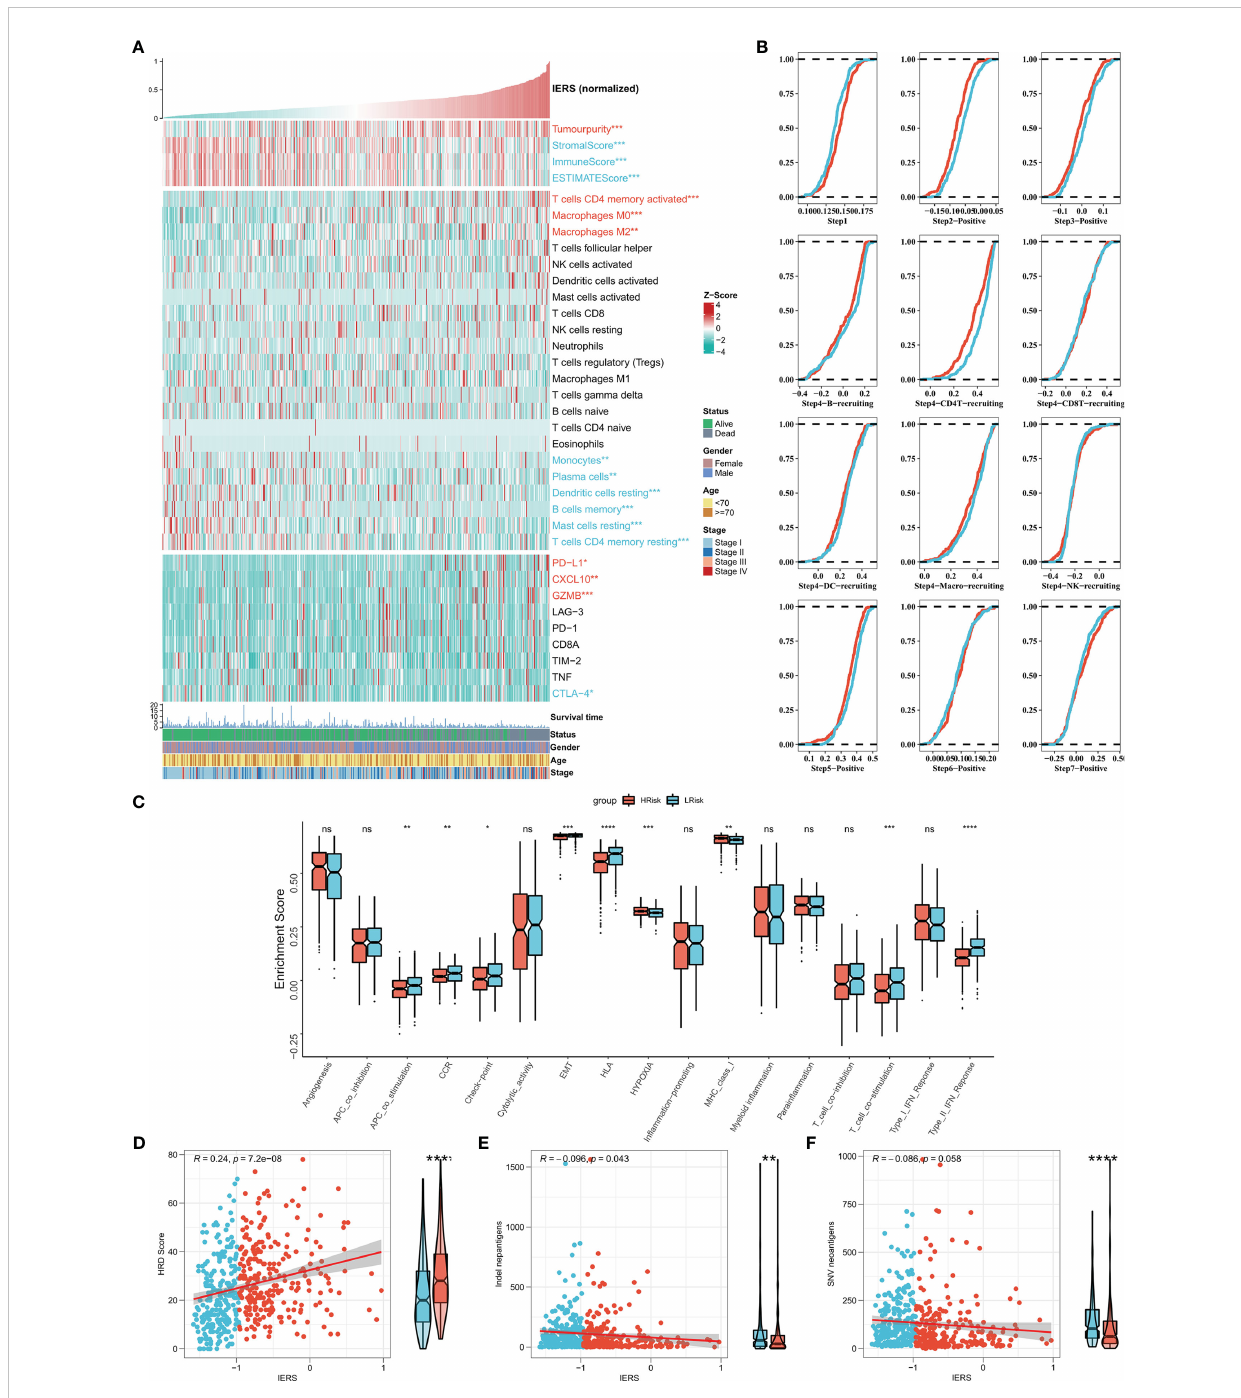
FIGURE 6 Dissecting the heterogeneity of TME among IERS subgroups (A) Heat map showed the IERS landscape, including the Estimate score, immune cell in fi ltration abundances, and immune checkpoint expression. (B) Cumulative distribution plots show differences in immune processes between different IERS subgroups. (C) The box plot showed the difference between different IERS subgroups for the interesting pathway calculated by the ssGSEA algorithm. The correlation between IERS and (E) HRD score, (D) Indel neoantigens, and (F) SNV neoantigens. ns P<0.05, *P<0.05, **P<0.01, ***P<0.001,